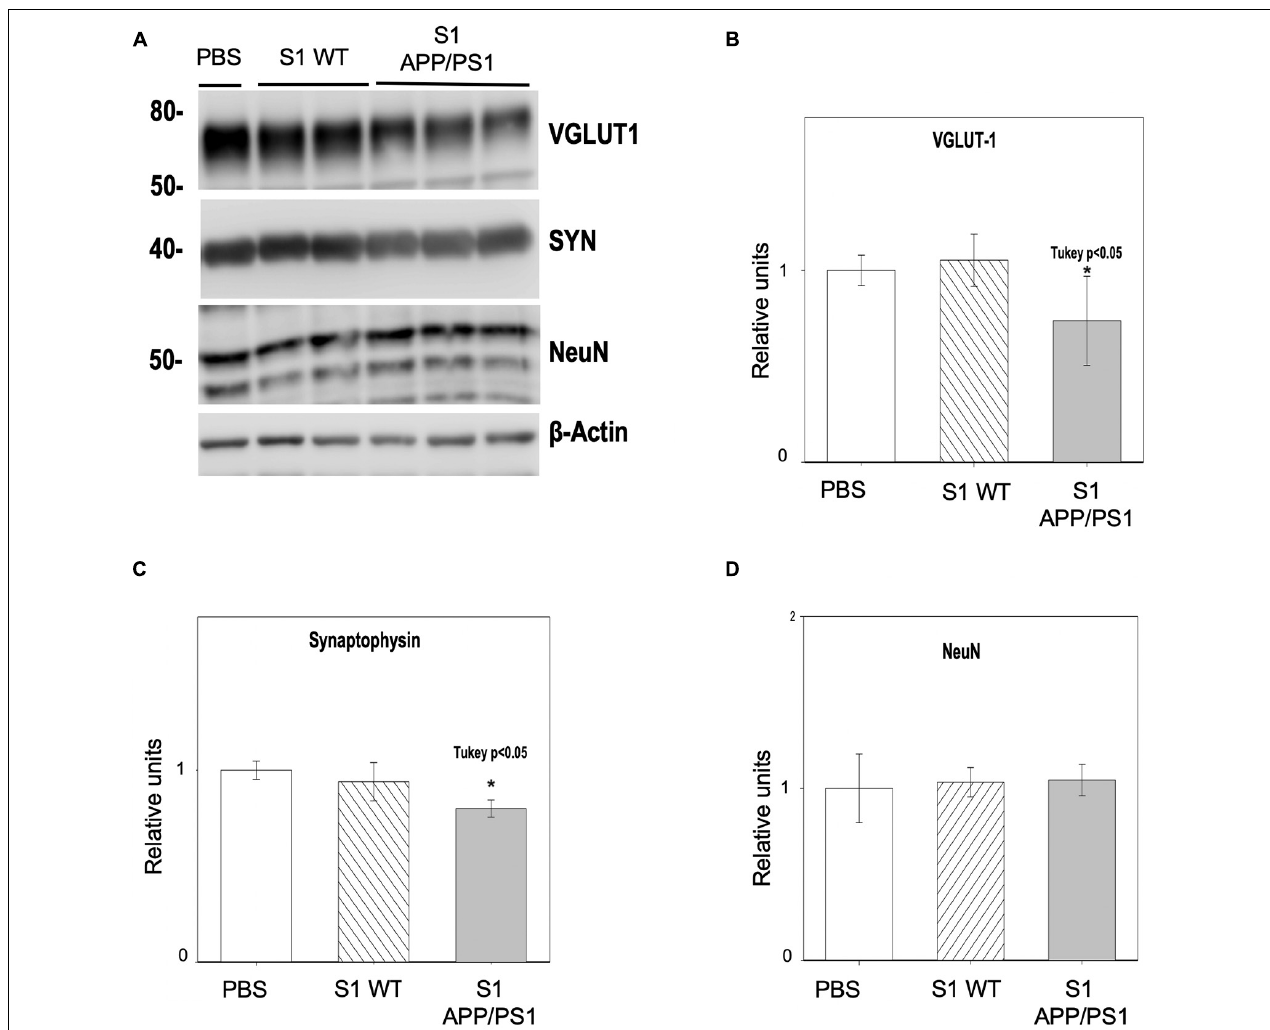
FIGURE 8 | Hippocampal soluble fractions from young APP/PS1 mice reduce the synaptic protein content in vitro . Primary neuronal cultures were incubated with soluble fractions (S1) from 6-month-old APP/PS1 or WT mice for 48 h ( n = 3/group). Incubation with PBS was used as an additional control. Analysis by Western blot (A) and quantification showed a significant decrease in the protein levels of the presynaptic markers VGLUT1 (B) [ANOVA F ( 2 , 9 ) = 4.38 P = 0.05; Tukey’s * p < 0.5] and SYN (C) [ANOVA F ( 2 , 9 ) = 8.03 P = 0.05; Tukey’s * p < 0.05] after incubating with APP/PS1 S1, but not when incubating with control fractions. As